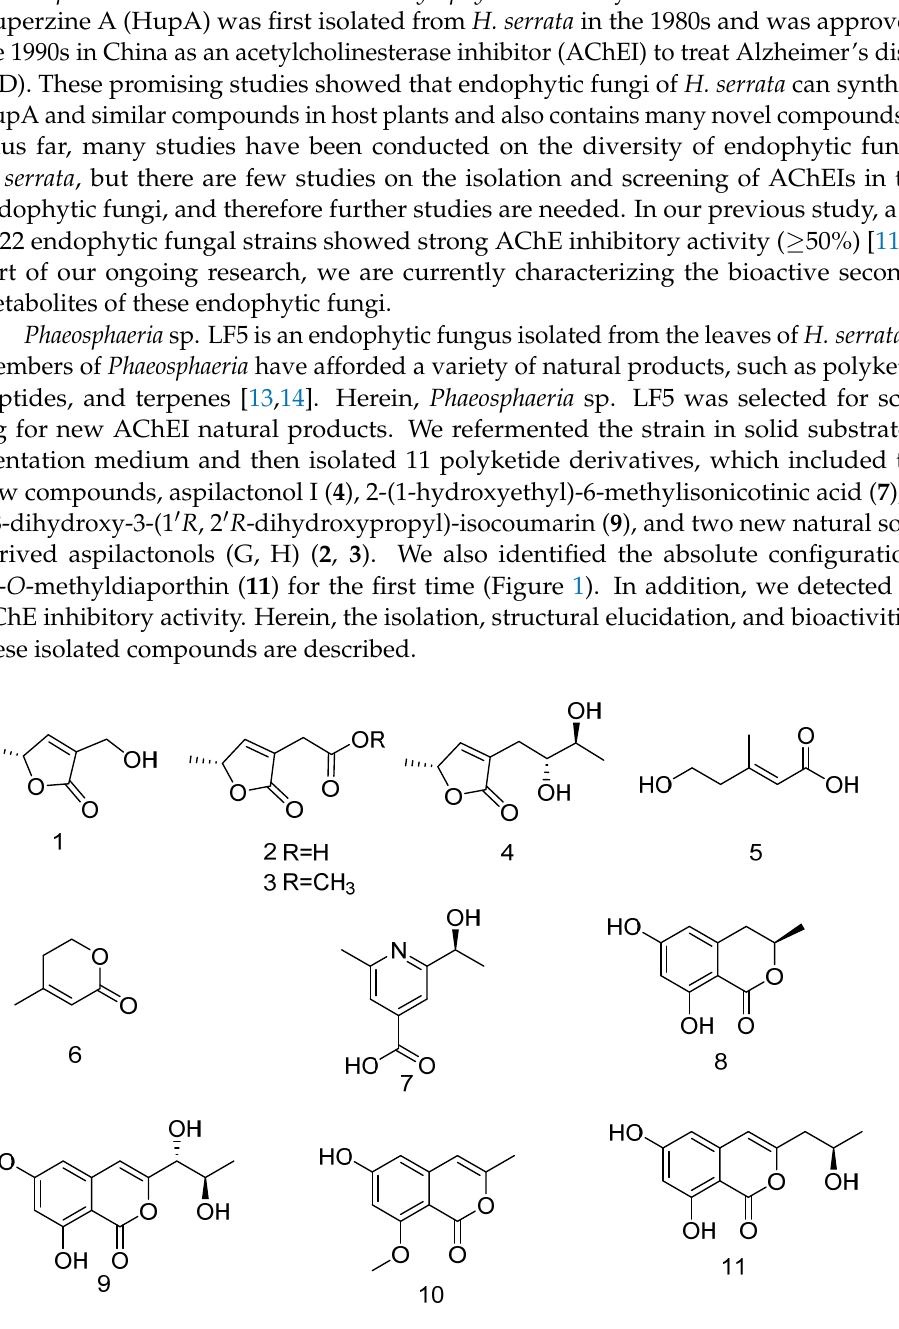
Figure 1. Chemical structure of compounds 1–11 .